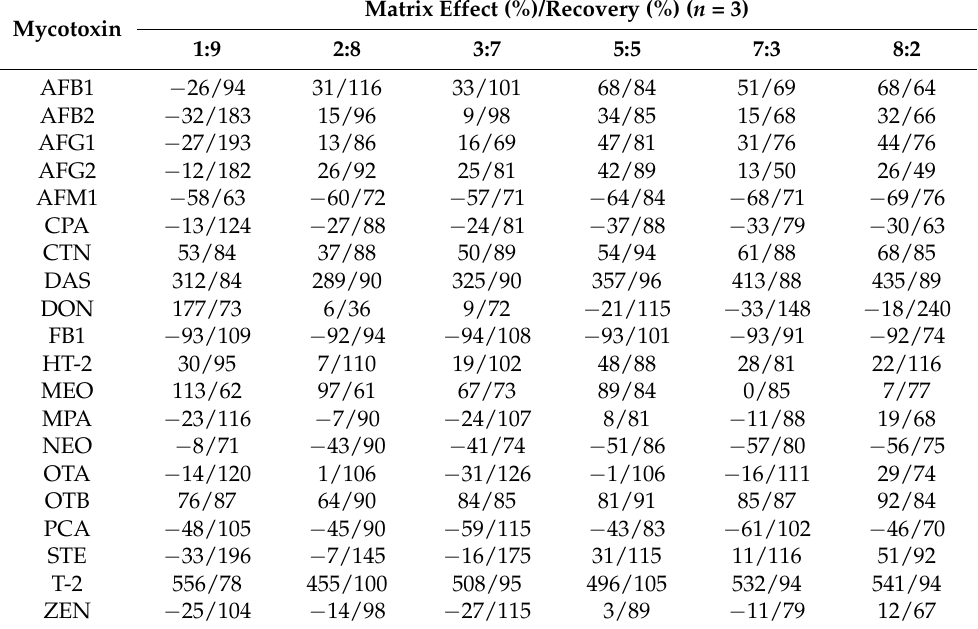
Table 2. Matrix effect and recovery percentage obtained by applying various wine/water ratios ( v/v ).